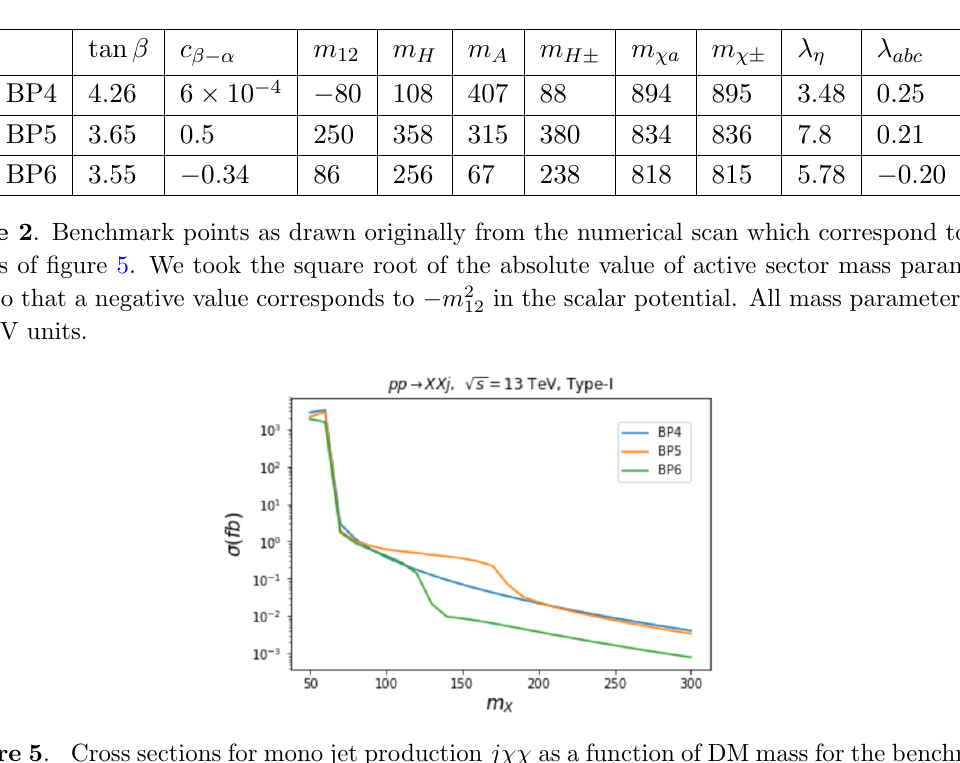
was also varied so that the portal (cid:17)